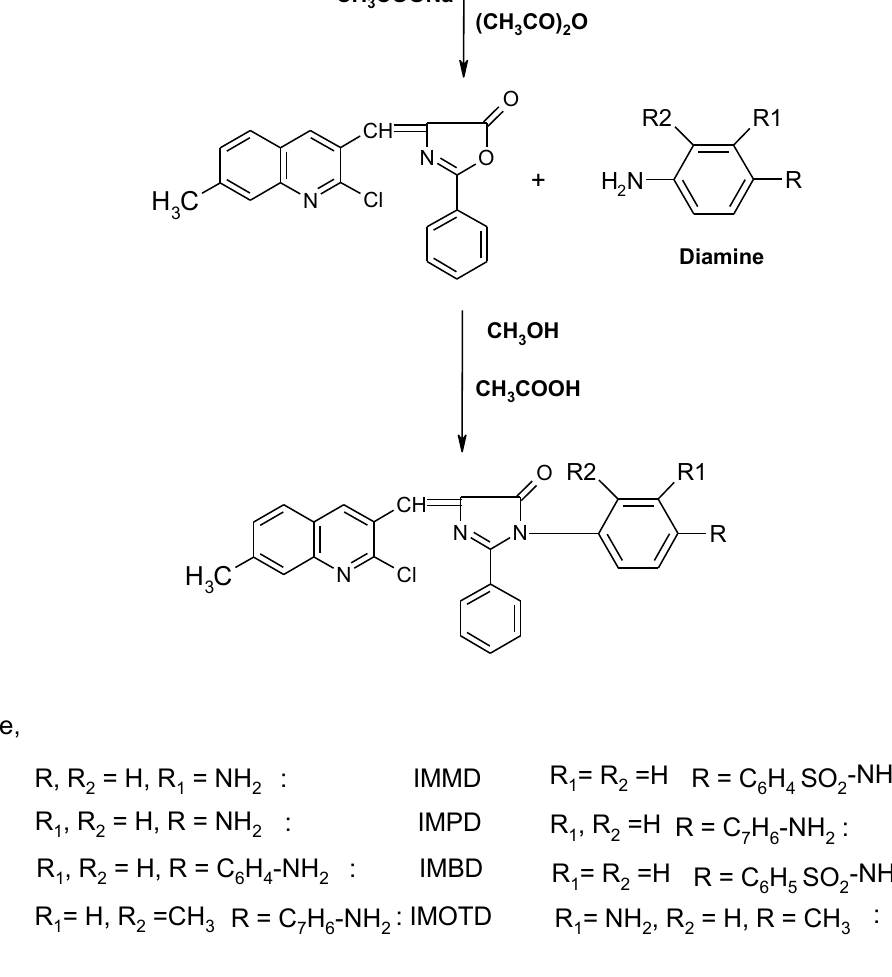
Scheme 1 Reaction protocol of 2-chloro-7-methyl-3-formyl quinoline based imidazole